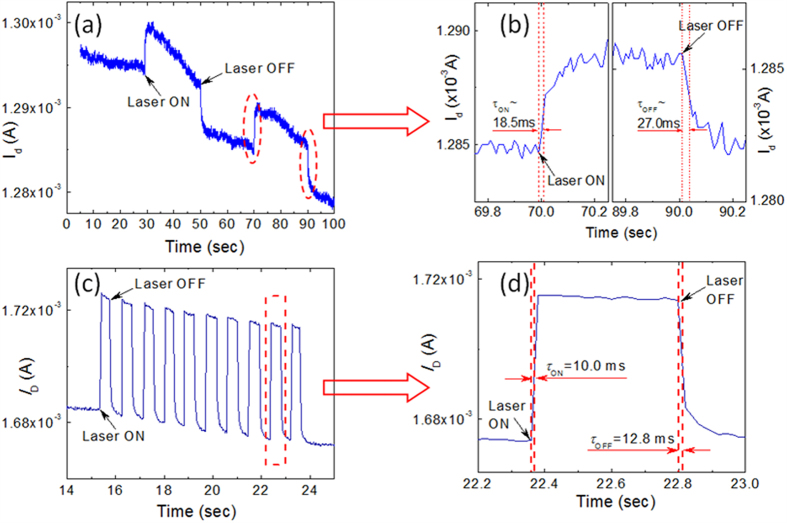
Dynamic response ID vs. time curves of graphene/GaSe-nanosheet hybrid GFET upon 532 nm incident laser ON/OFF modulation.(a,b) before vacuum annealing, incident laser intensity ~188 mW/cm2. (c,d) after vacuum annealing, incident laser intensity ~198 mW/cm2. (a,c) are full dynamic response spectra, (b,d) shows zoom-in view of rise/decay. Response time was estimated using magnitude change criteria. Back gate voltage VBG = 0 V, and source-drain voltage VSD = 1 V for all measurements.